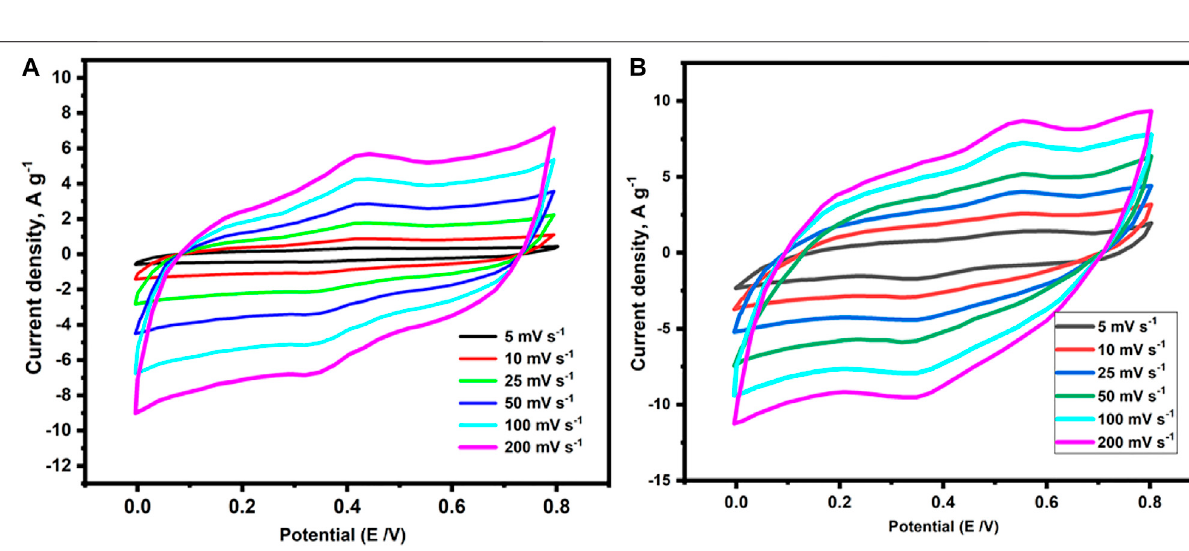
Frontiers in Chemistry |